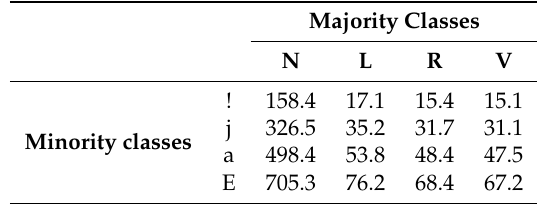
Table 2. IR values between majority and minority